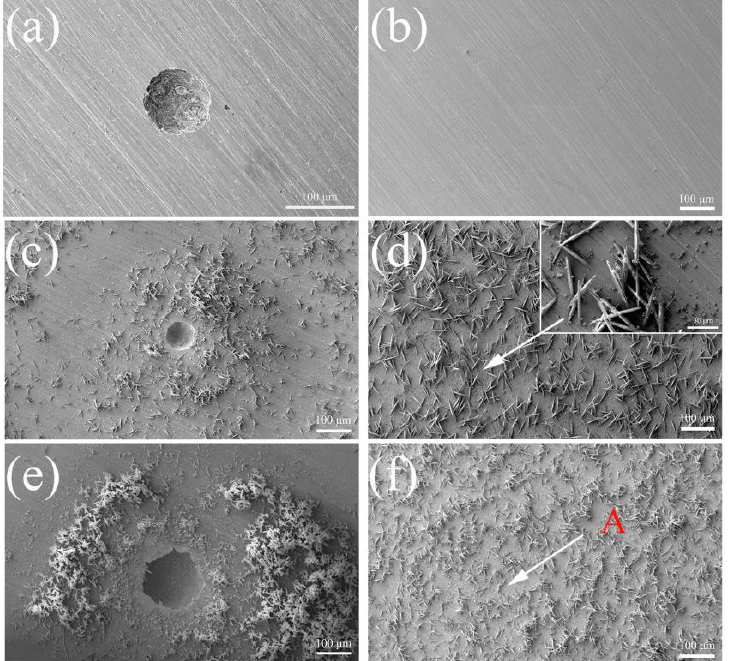
Figure 7. Typical SEM-SE morphologies ( × 500) of specimen surfaces after the polarization measure- ment in the synthetic tap water solutions with different concentration ratios: ( a , b ) 1, ( c , d ) 6, and ( e , f ) 8 times.